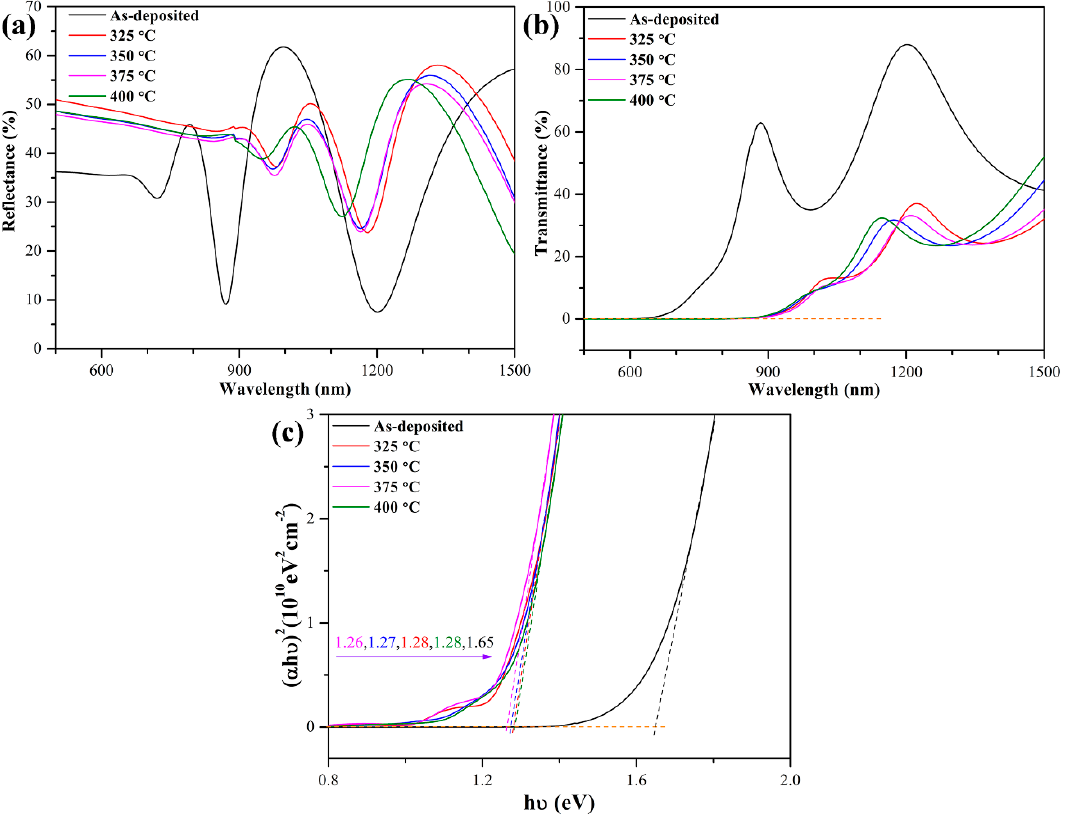
Figure 5. Optical characterizations of Te-Sb 2 Se 3 thin films at different annealing temperatures. ( a ) Reflection spectra, ( b ) Transmission spectra, and ( c ) Plot of ( α h υ ) 2 vs. h υ for obtaining the direct band gap.